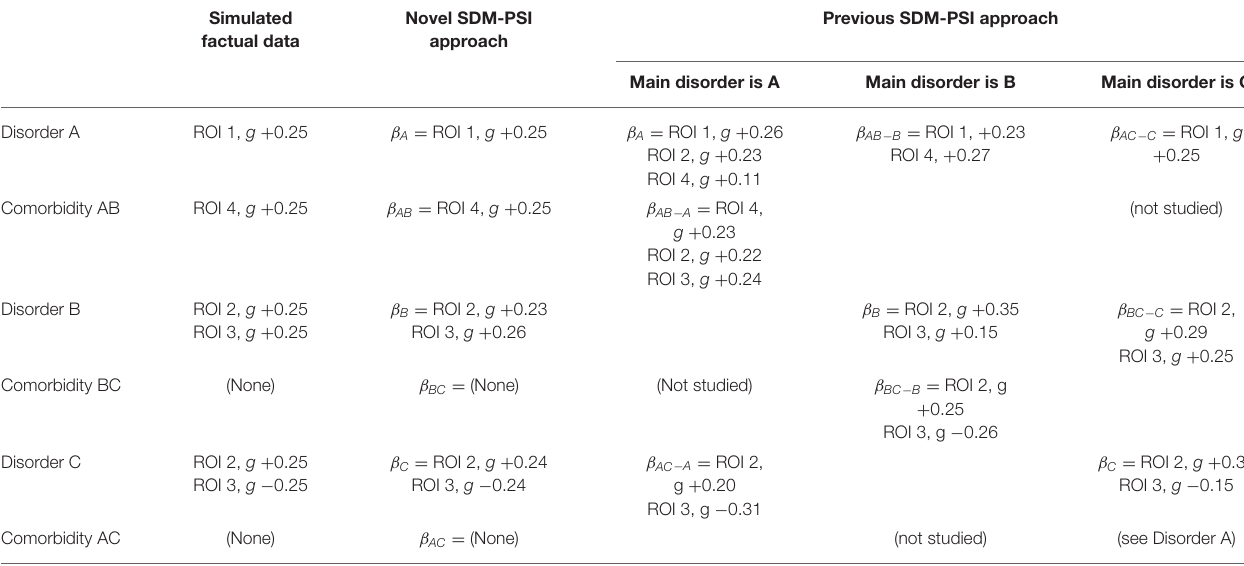
TABLE 2 | Results of the novel approach validation after creating the simulated data with double